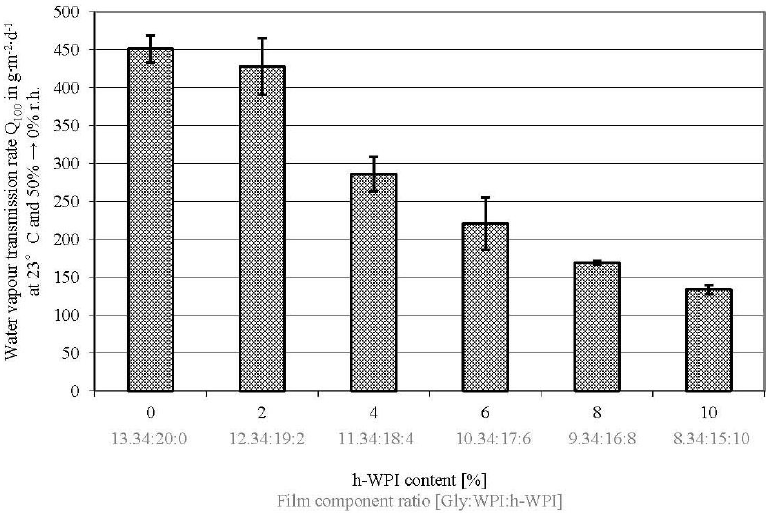
Figure 2. Effect of increased h-WPI content (reduced protein M content on the water vapor transmission rate of WPI-based